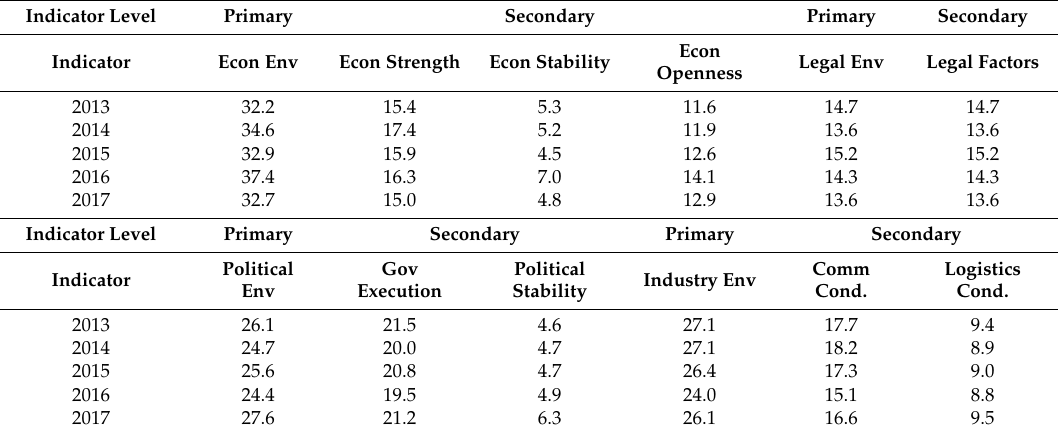
Table 6. Weights of indicators of the second-category